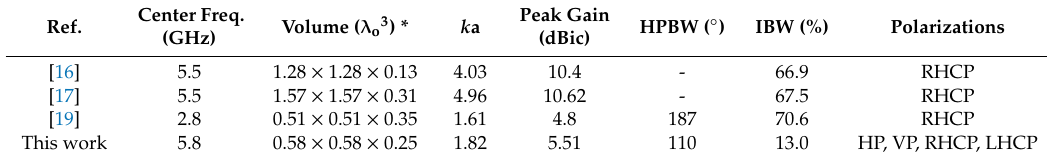
Table 3. Comparison table with the previously reported crossed-dipole